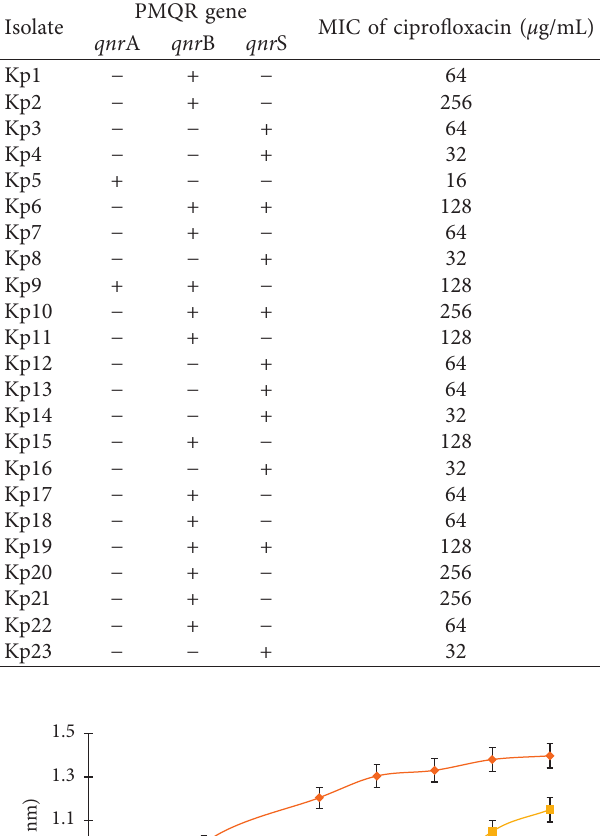
Table 2: Minimum inhibitory concentration (MIC) and plasmid- mediated quinolone resistance (PMQR) genes in Klebsiella pneu- moniae isolates. Isolate